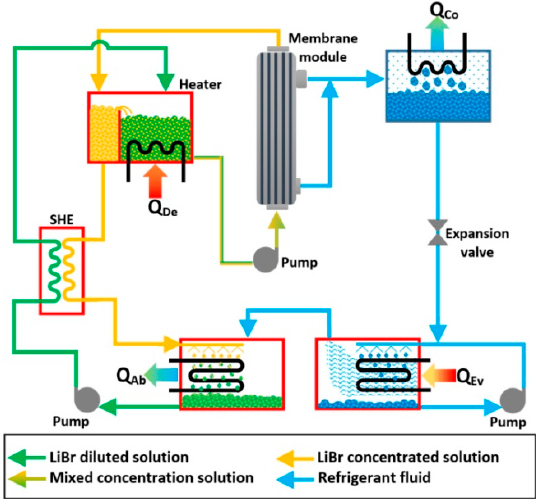
Figure 4. Membrane absorption system proposed by Wang et al. [51].